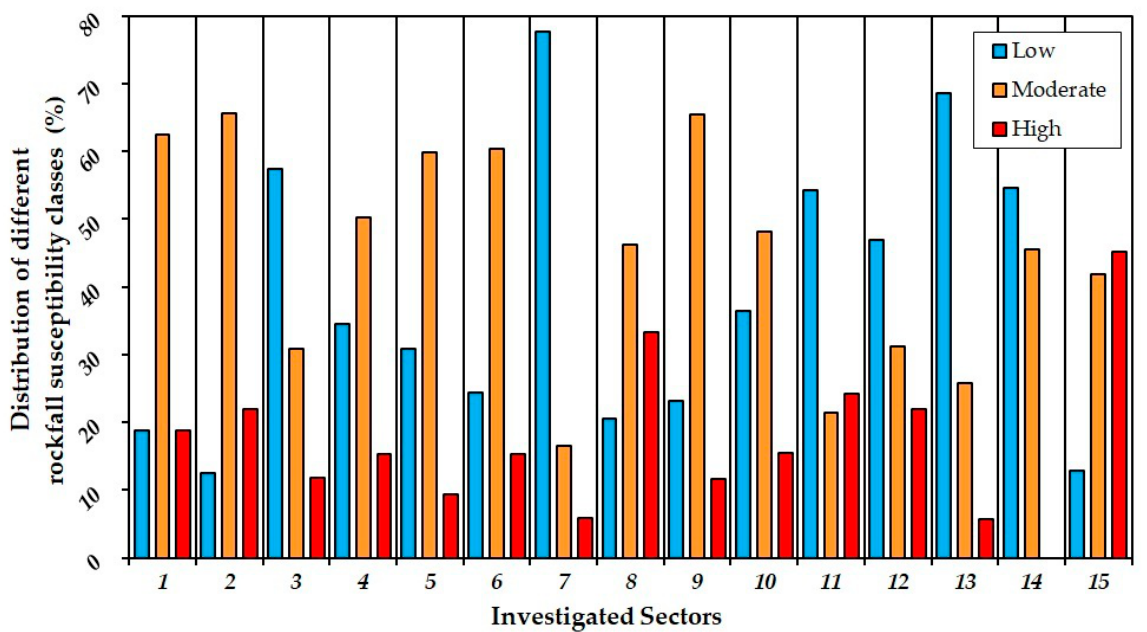
Figure 12. Summarized outcomes of QPROTO plugin. Blue, orange, and red colors indicate the “low”, “moderate”, and “high” degree of rockfall runout invasion for each sector analyzed, respectively.